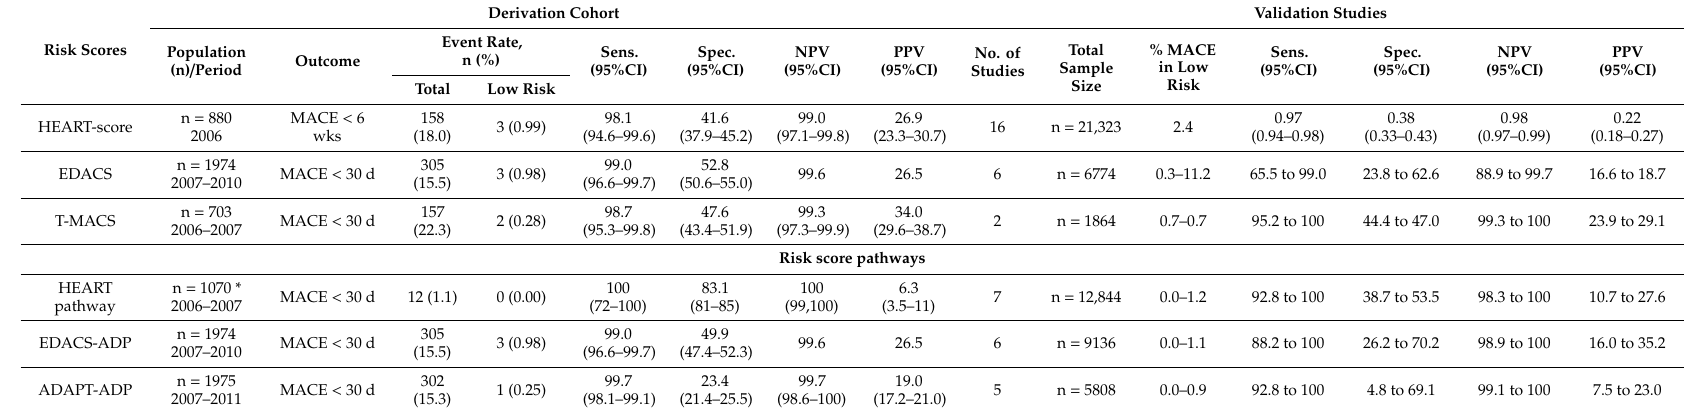
Table 1. Risk scores used at presentation for suspected non-ST-segment elevation acute coronary syndrome